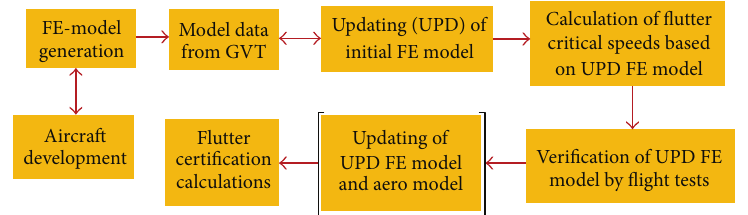
Figure 1: Actual verification and validation process of aeroelastic aircraft models